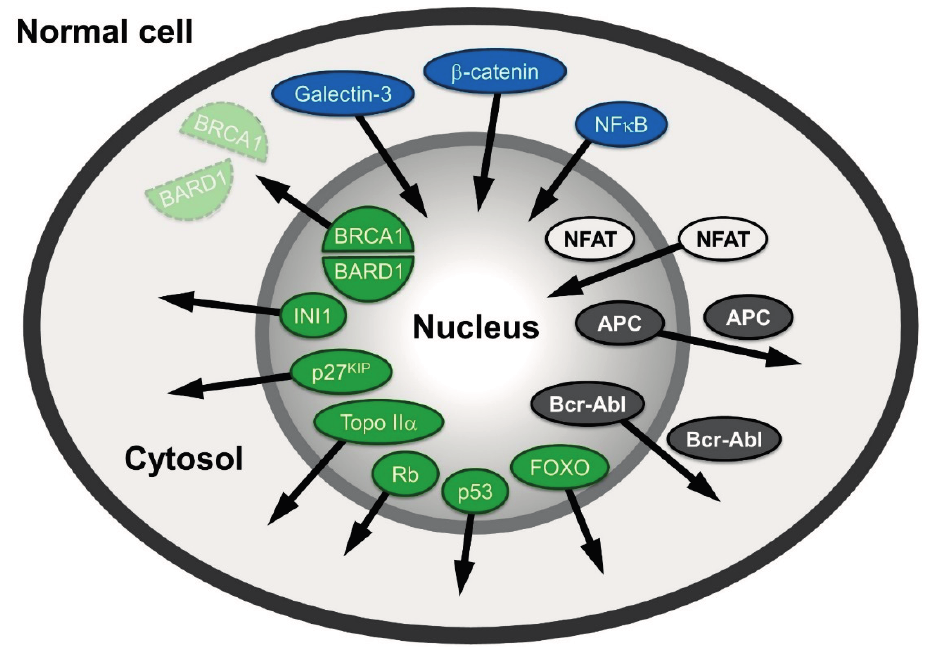
Figure 1. Spatial relocalization of (proto-) oncoproteins in cancer cells compared to normal cells. In cancer cells, proteins mislocalized into the nucleus are depicted in blue; in the cytoplasm, they are colored green; and those shifting from nuclear and cytoplasmic distribution to either cytoplasmic or nuclear are depicted in grey and white, respectively. The arrows indicate the direction of the shift in cancer cells. The function of the proteins depicted here is described in the main